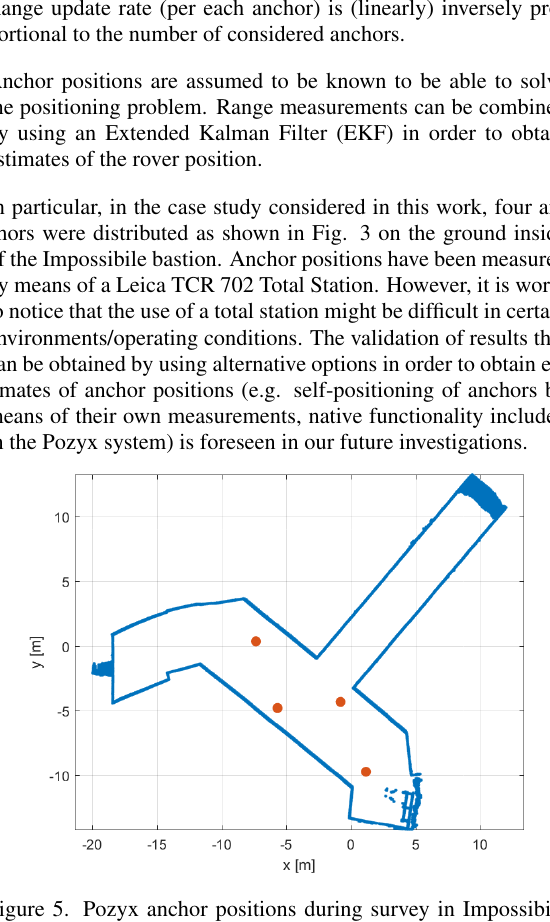
Figure 5. Pozyx anchor positions during survey in Impossibile